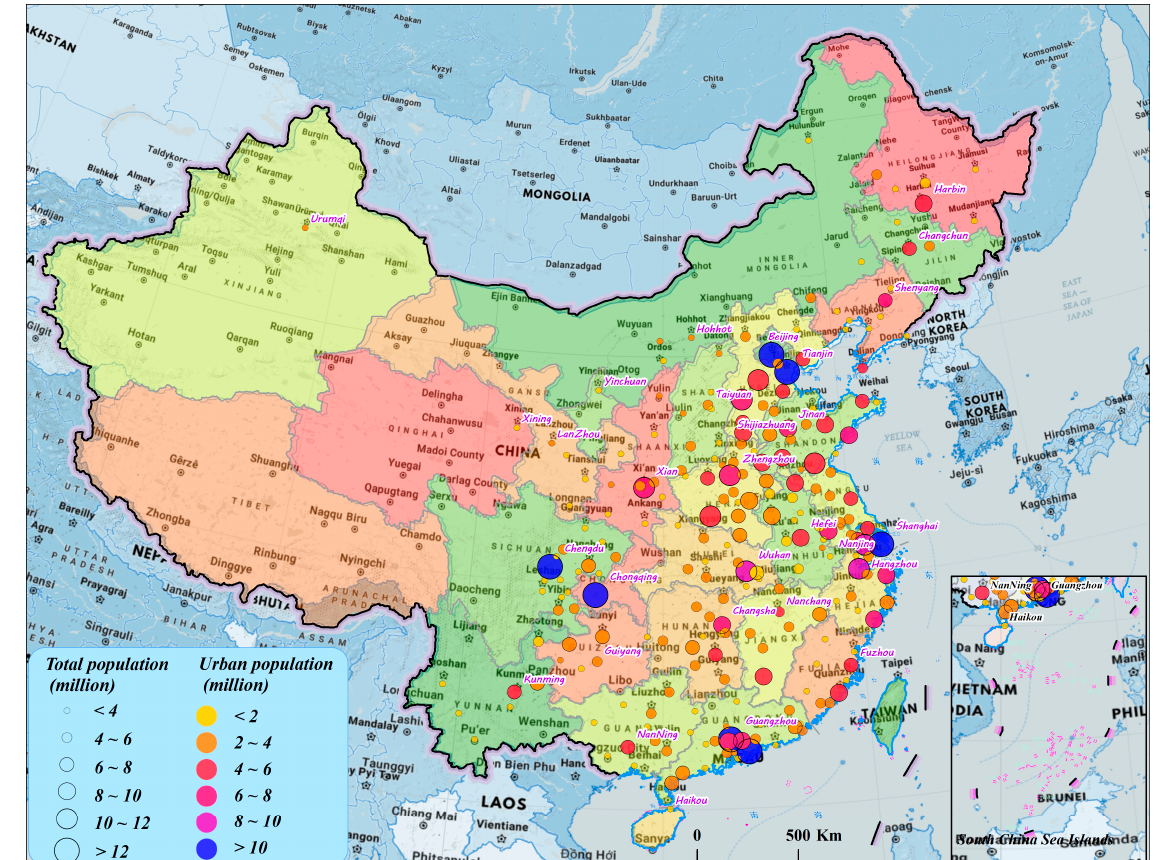
Figure 1. The 234 sample cities with total population larger than 2 million in 2019 in China.